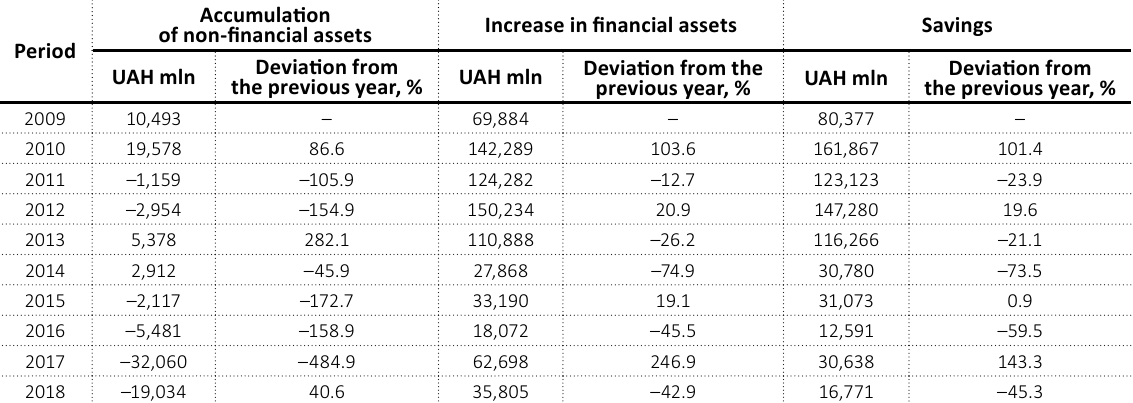
Table 6. Savings of the population of Ukraine, UAH mln Accumulation of non-financial assets Increase in financial assets Period UAH mln Deviation from the previous year, % UAH mln